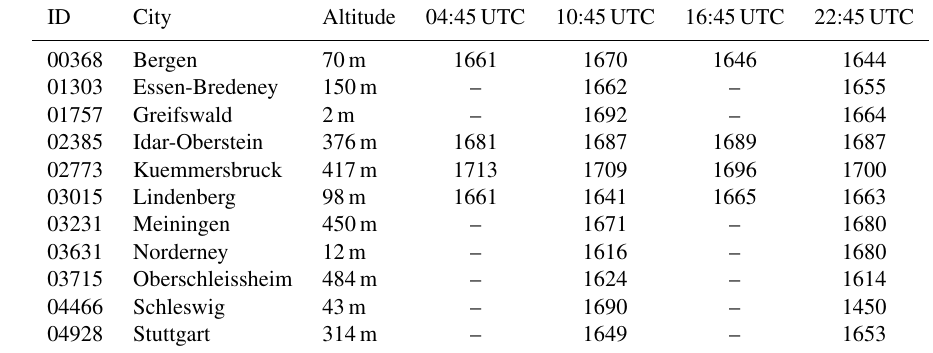
Table 2. Overview of radiosonde observations. The last four columns show the number of observations between 2014 and 2018 at synoptic main times.